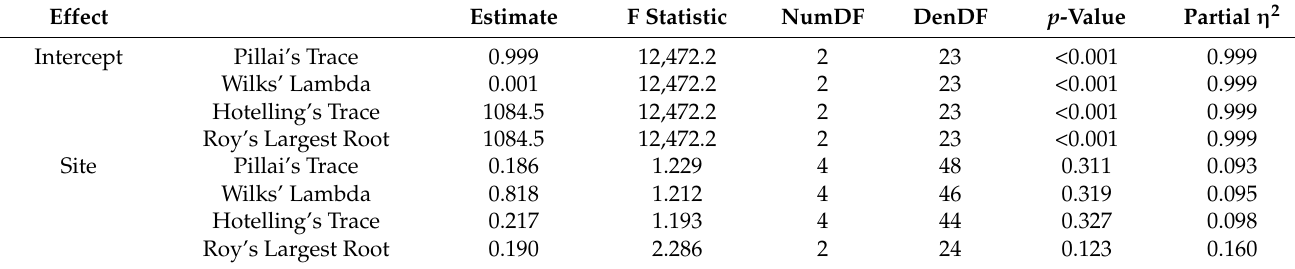
Table A2. Multivariate tests of SOS (start of growing season), EOS (end of growing season), and LOS (length of growing season, respectively) by site from MANOVA.